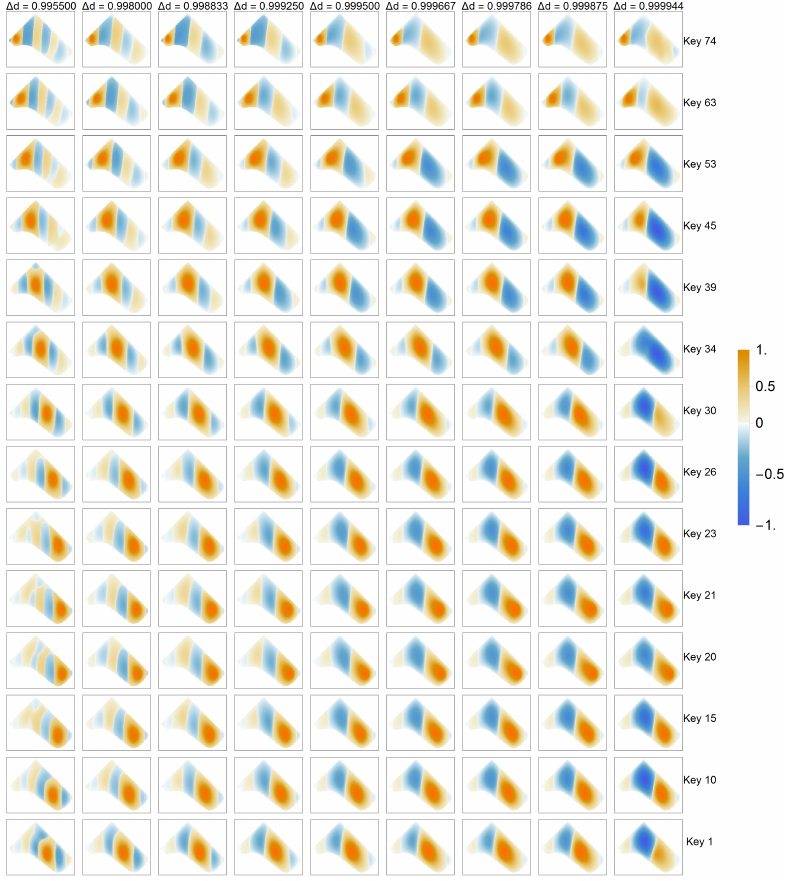
Figure 4. Real valued amplitudes of the FDM raw soundboard simulation, driven sinusoidally with 26 Hz at 14 impact points at bridge positions and simulating with nine damping strength values with decreasing damping from right to left. The very left column, therefore, represents the forced oscillation patterns for maximum damping used. The maximum amplitudes of the patterns follow the impact point of driving the soundboard. Leaving the respective impact points leads to a decrease in amplitude of a traveling wave. Each row of the plot shows the change of this pattern when decreasing the damping. With decreased damping, modal patterns appear gradually more and more. Still, even with minimum damping at the very right of the plot, the modal patterns of different impact points are considerably different. Therefore, a certain damping leads to a mixture of the eigenmode with a pattern emphasizing the impact